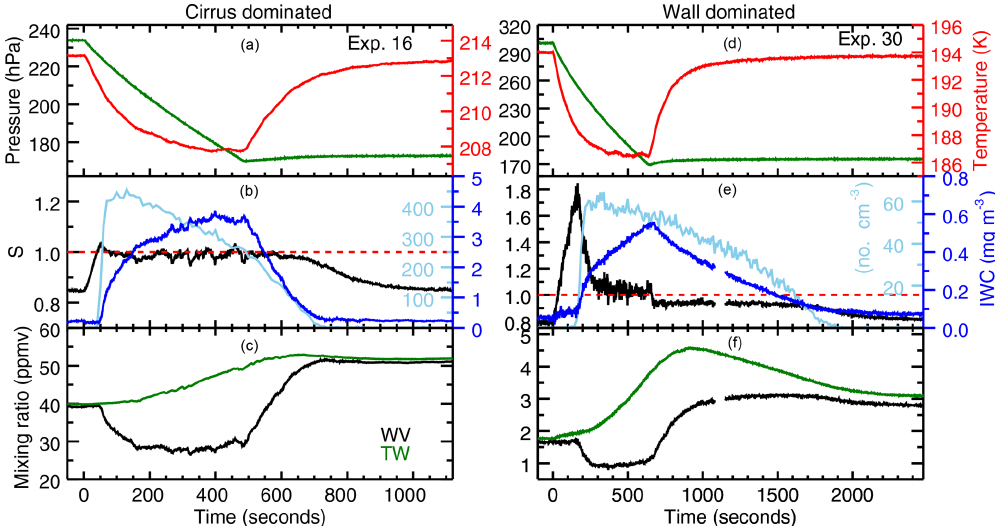
Figure 2. Examples of experiments in which vapor is controlled by cirrus uptake (a–c) and wall flux (d–f) . Experiment 16 (a-c) is a heterogeneous nucleation experiment onto ATD, and Experiment 30 (d–f) is a homogeneous nucleation experiment with SA aerosol. The top panels of each plot show the pressure (green) and temperature (red) evolution. The action of the chamber pumps results in a pseudo-adiabatic expansion that cools the chamber gas rapidly at first, then more slowly until the cooling is balanced by heat flux from the chamber walls. The chamber gas warms as soon as the pumps have stopped. The middle panels show Murphy–Koop (MK) saturation (red dashed line), measured saturation (black), ice particle number (light blue), and the cloud’s ice water content (dark blue). Ice nucleation starts at the peak in saturation, and is followed by a sharp increase in particle number and rapid cloud growth. Saturation relaxes back to a constant value, where it stays until the pumps turn off. In the cirrus-dominated experiment, that value is the saturation vapor pressure over ice. In the wall flux-dominated experiment, that value of about 6% supersaturation is what is required to drive enough ice growth to balance the wall outgassing. When the pumps stop, the vapor pressure returns to the wall-controlled value in the cirrus-controlled experiment, but in the wall flux-controlled experiment the decay rate is limited by wall uptake. The bottom panels show total water (green) and water vapor (black). The small data gap in Experiment 30 at around 1100s is due to realignment of the chamber’s White cell